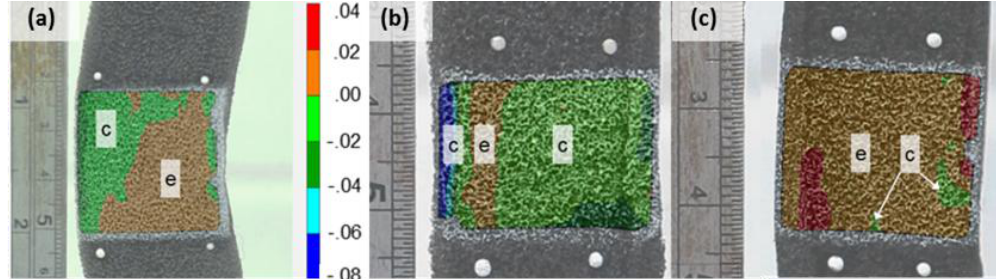
Figure 3. Contour plot showing lateral strain at maximum compression in ( a ) 120 °C, 20 min ‘buckling’ sample (containing legend, same for all); ( b ) 140 °C, 60 min sample; ( c ) 180 °C, 60 min sample [e = expansion, c = contraction].